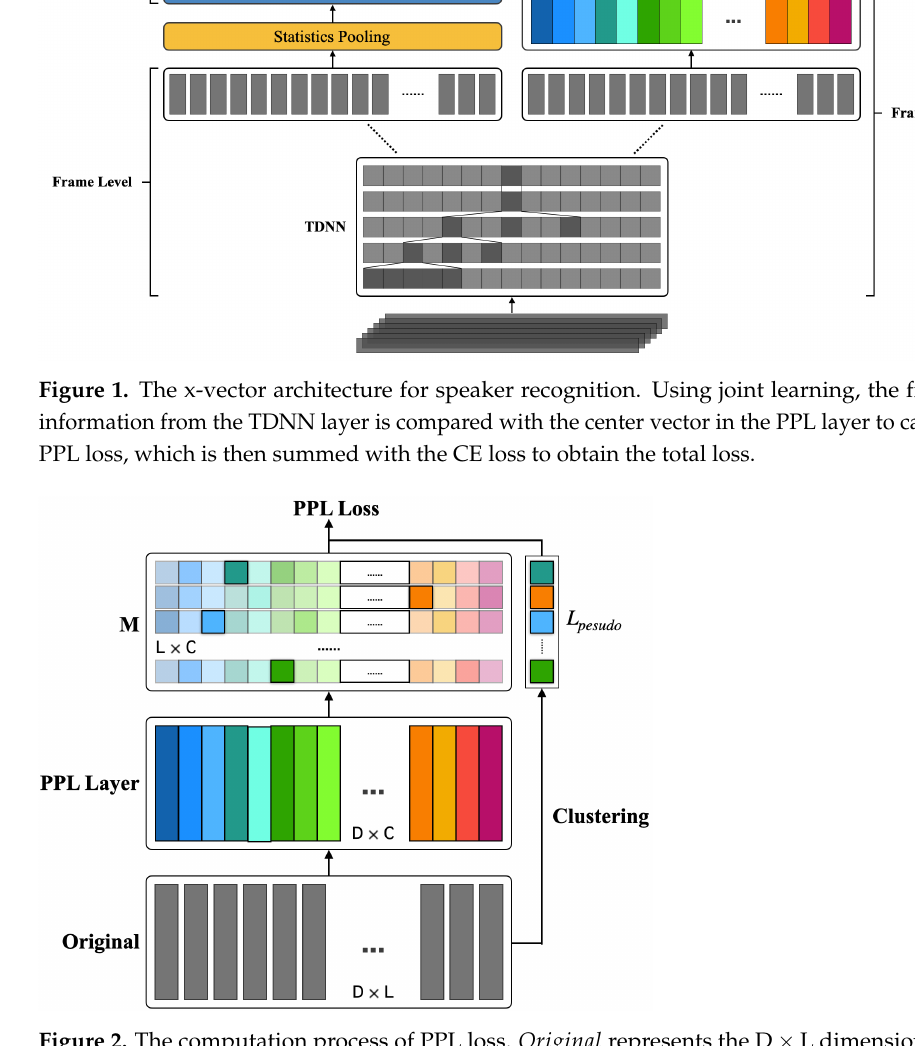
Figure 2. The computation process of PPL loss. Original represents the D × L dimensional feature vectors output from the TDNN layer, and PPL layer represents the D × C dimensional center vectors maintained by the learnable dictionary encoding (LDE) layer. The similarity matrix M is calculated by the feature of the TDNN layer and the transpose feature of the LDE layer, obtaining a result of a L × C matrix. In the matrix M , each row represents the similarity between each frame feature of the input and the C center vectors in the PPL layer, and each color represents a class. After that, the corresponding class of each frame feature is the pseudo-phoneme label L pseudo according to the clustering result. Finally, the CE loss is calculated between M and L pseudo to obtain the PPL